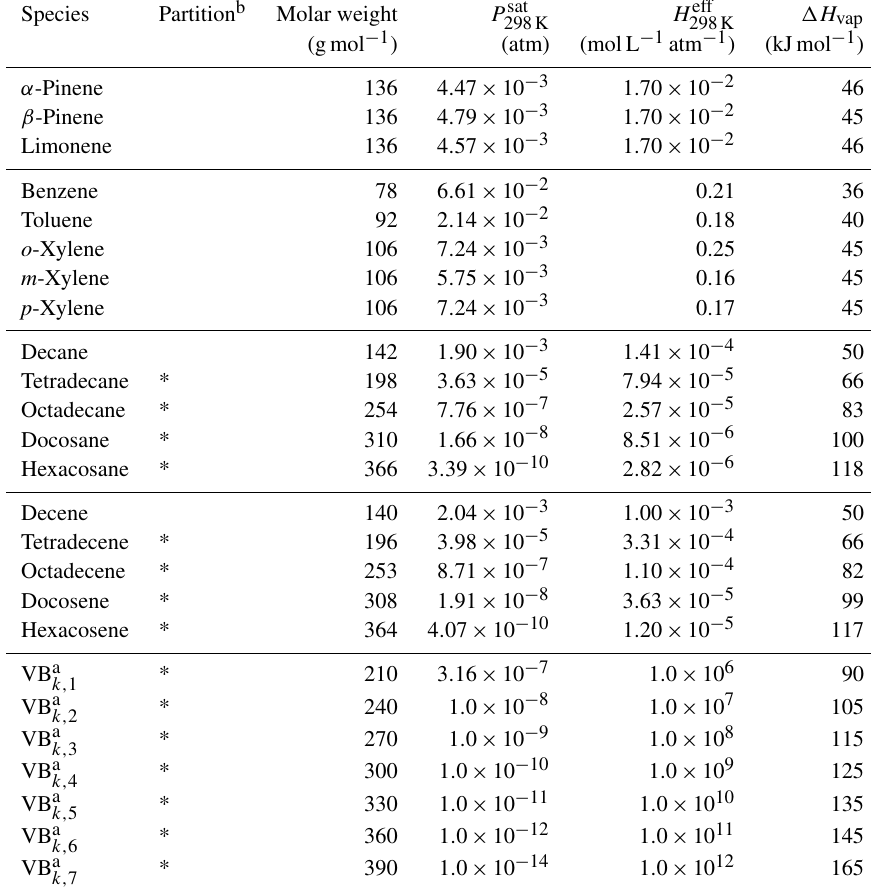
Table 1. List of the VBS-GECKO species and associated properties. Species Partition b Molar